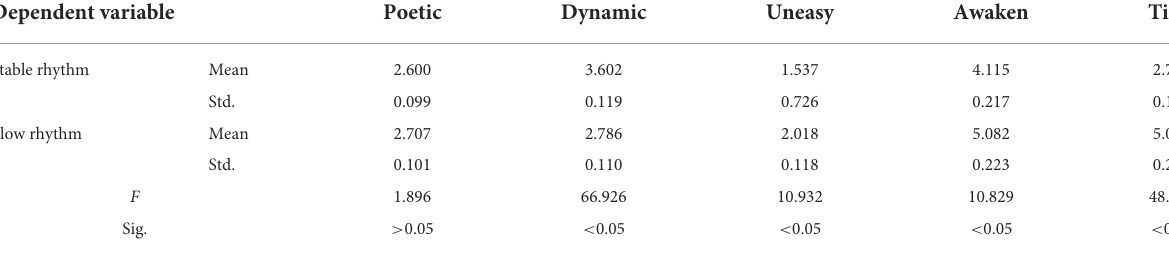
TABLE 6 Psychological and emotional impact of live short music videos on viewers.